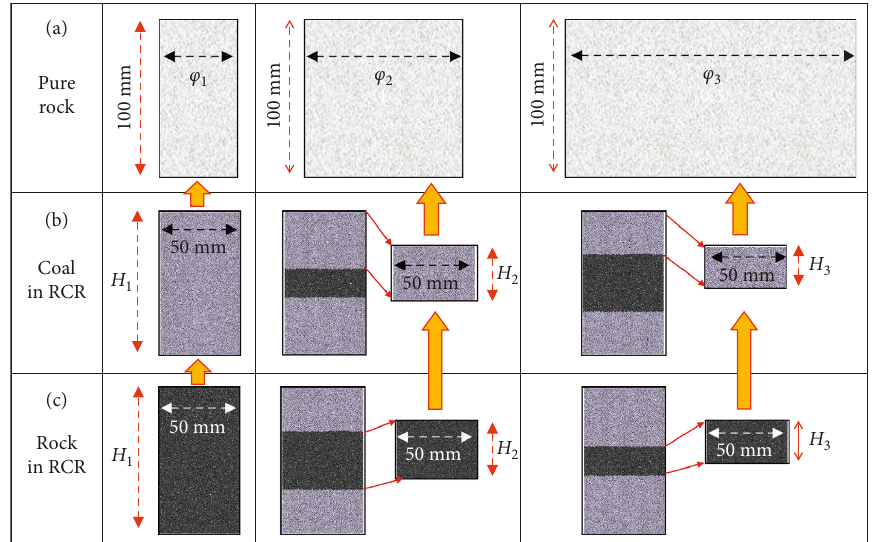
Figure 6: Size effect of samples. (a) Samples with a constant height (100mm) employed in Equation (2). (b) Rock components with a constant diameter of 50mm and different heights ( H 1 ∼ H 3 ) in RCR samples. (c) Coal bodies with a constant diameter of 50mm and different heights ( H 1 ∼ H 3 ) in RCR samples.